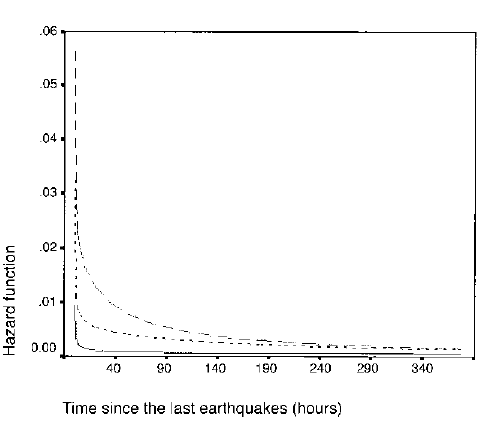
(solid line). Hazard n = 3.95 (dashed line) and for n